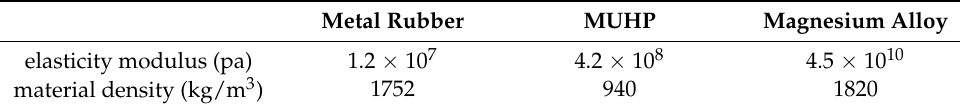
Figure 8. Photos of the three new isolators. Table 2. Material parameters of the isolators.